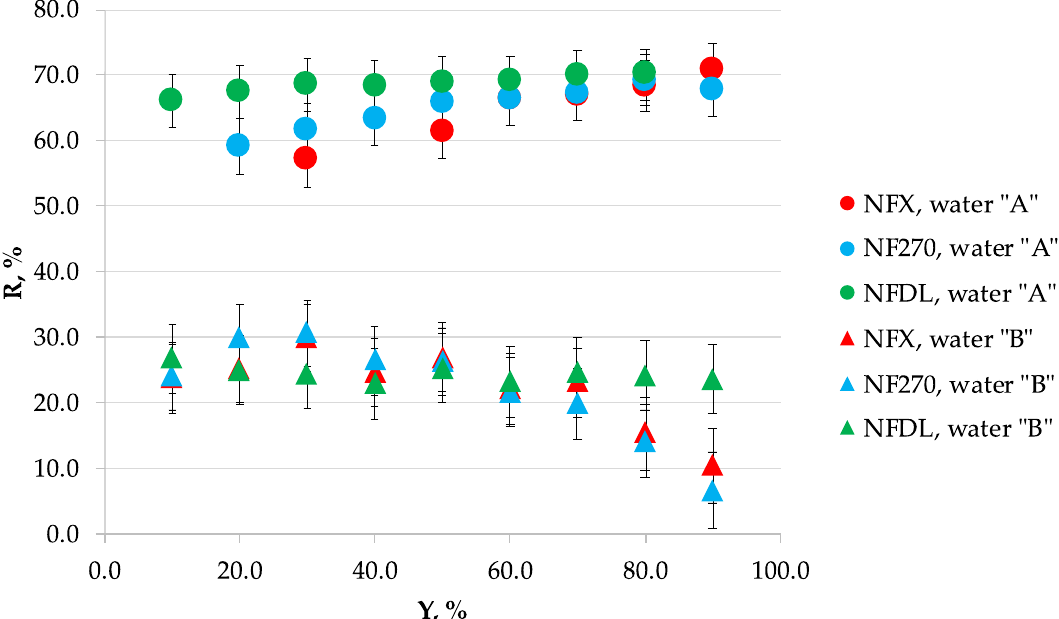
Figure A2. Rejection coefficient, R, of Cl ‐ as a function of permeate recovery, Y, for NFX, NF270 and NFDL nanofiltration membranes and mine waters “A” (0.384 g/L as Cl − , 1.02 g/L as SO 42 − , 0.107 g/L as Na + , 0.142 g/L as Mg 2+ , 0.312 g/L as Ca 2+ ) and “B” (33.2 g/L as Cl ‐ , 0.937 g/L as SO 42 − , 19.5 g/L as Na + , 0.990 g/L as Mg 2+ , 0.771 g/L as Ca 2+ ).